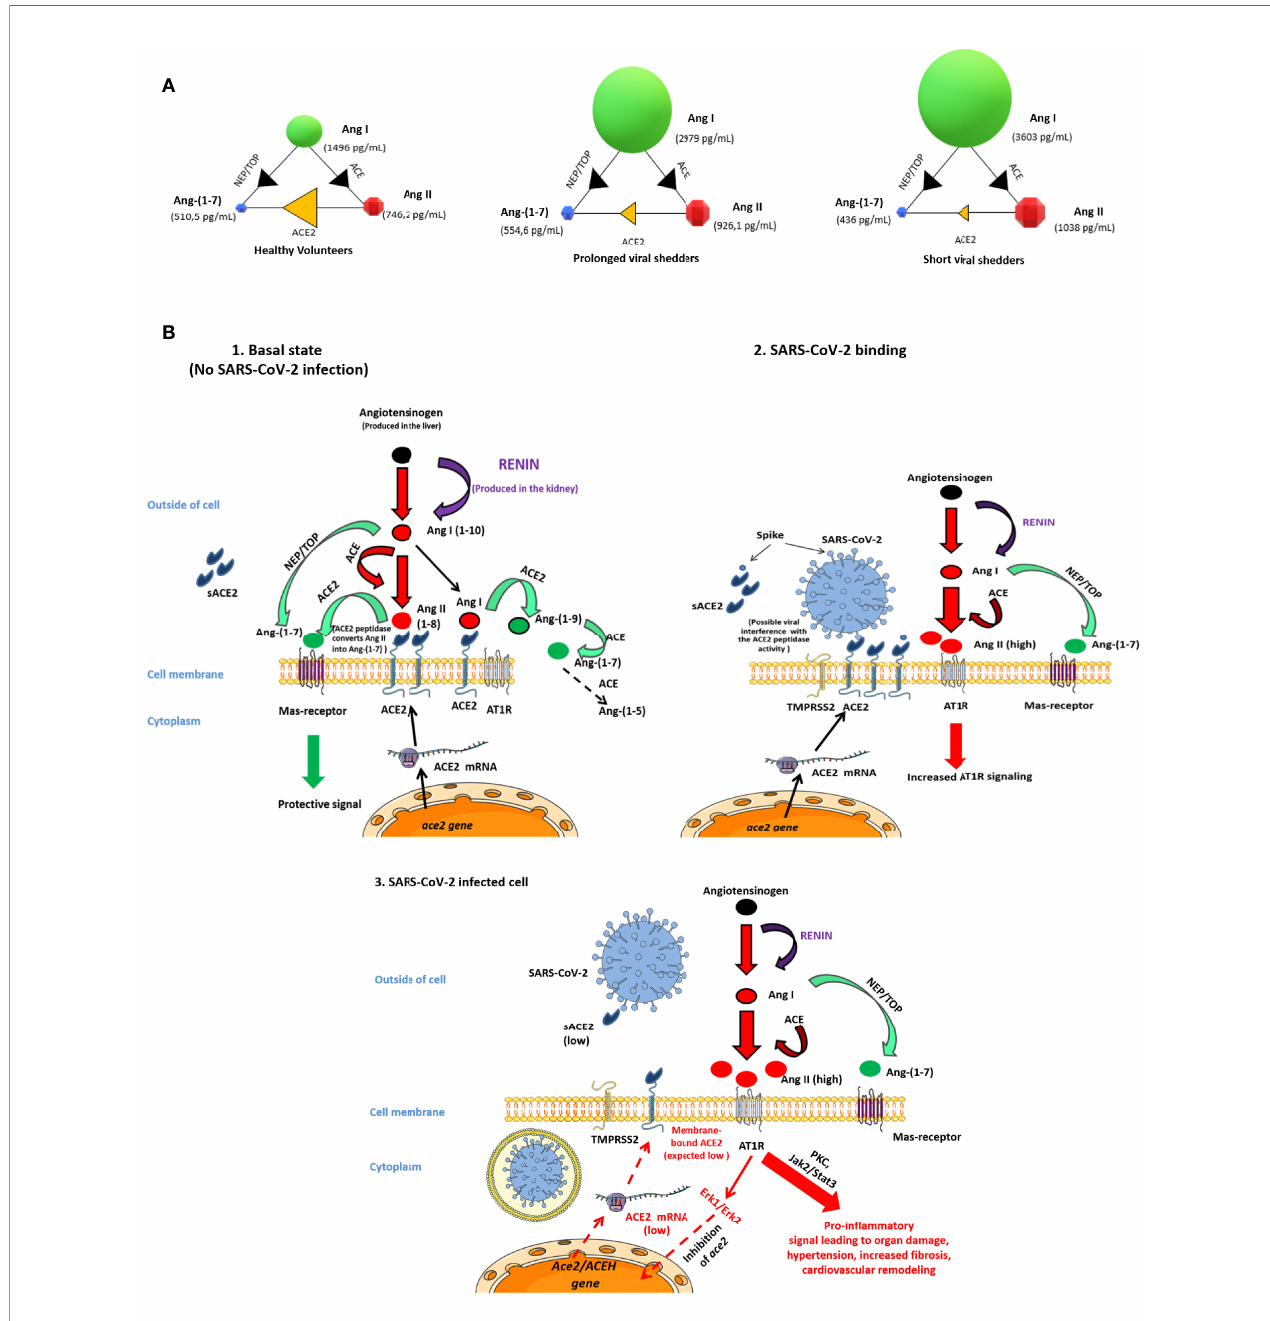
FIGURE 5 | Schematic representation of the possible dysfunction of the angiotensin metabolites pathway in COVID-19 patients. (A) Modelization of the concentration of angiotensin metabolites in plasma of healthy volunteers, prolonged viral shedders, and short viral shedders. For each group, the individual circles indicate the metabolite median concentrations, shown in pg/mL. The arrows between the circles mark the catalyzing reactions mediated by the indicated enzymes. (B) Schematic diagram of the renin-angiotensin system (RAS) cascade in a normal physiological state and in COVID-19 patients. Renin cleaves Angiotensinogen to Ang I which is further processed to the vasoconstrictor Ang II peptide by ACE. The upper left panel illustrates the Ang II pathway of Ang-(1-7) biosynthesis where ACE2 converts Ang II to Ang-(1-7) and also Ang I to Ang-(1-9) next converted in Ang-(1-7) by ACE peptidase, leading to protective signal through MAS-receptor. This is the physiological state. The upper-right panel illustrates the possible dysfunction of signals when SARS-CoV-2 is attached to its ACE2 receptor. Under this condition Ang-(1-7) synthesis through ACE2 is likely decreased, Ang II accumulates and, increased Ang II binding to AT1R - leads to proin fl ammatory signals that ultimately will trigger both tissues damage (in particular lungs and heart) and hypertension. The lower - panel illustrates that during COVID-19, the ACE2 mRNA expression is reduced leading to low surface expression of ACE2 (and plasma sACE2), Ang II is in excess in plasma, yet Ang-(1-7) remains synthesized through the NEP/TOP alternative pathway where neprilysin (NEP) and thimet oligopeptidase (TOP) convert Ang I to